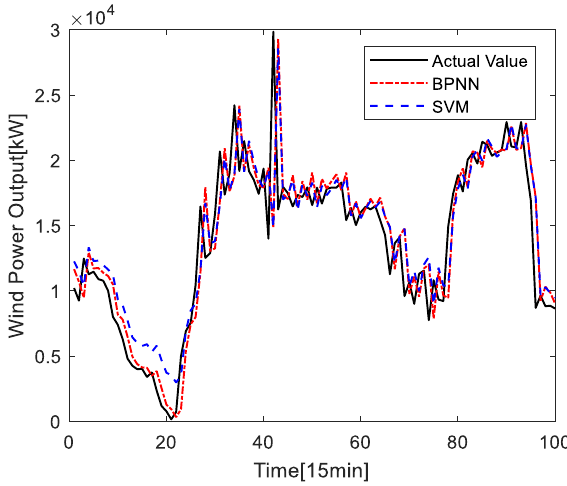
Figure 15. Prediction results of wind power output power in the No. 2 power system.